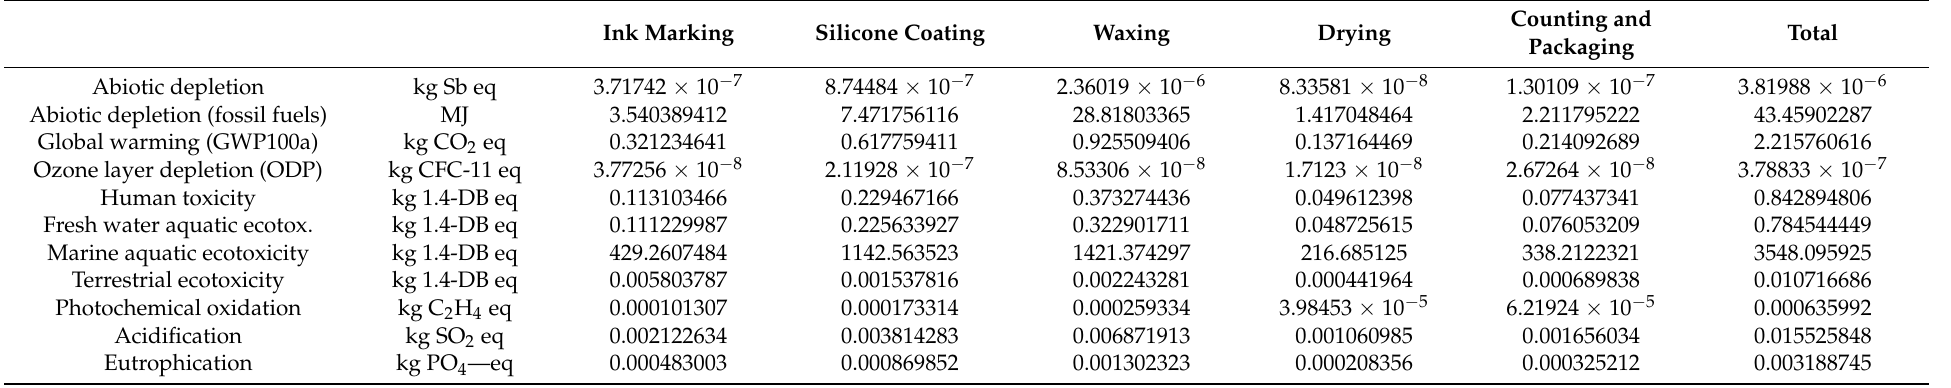
Table 17. Impact of stage 3 broken down by activities for the manufacturing process of turning stoppers of 2-pieces of 26 mm in diameter and 44 mm in length. Ink Marking Silicone Coating Waxing Drying